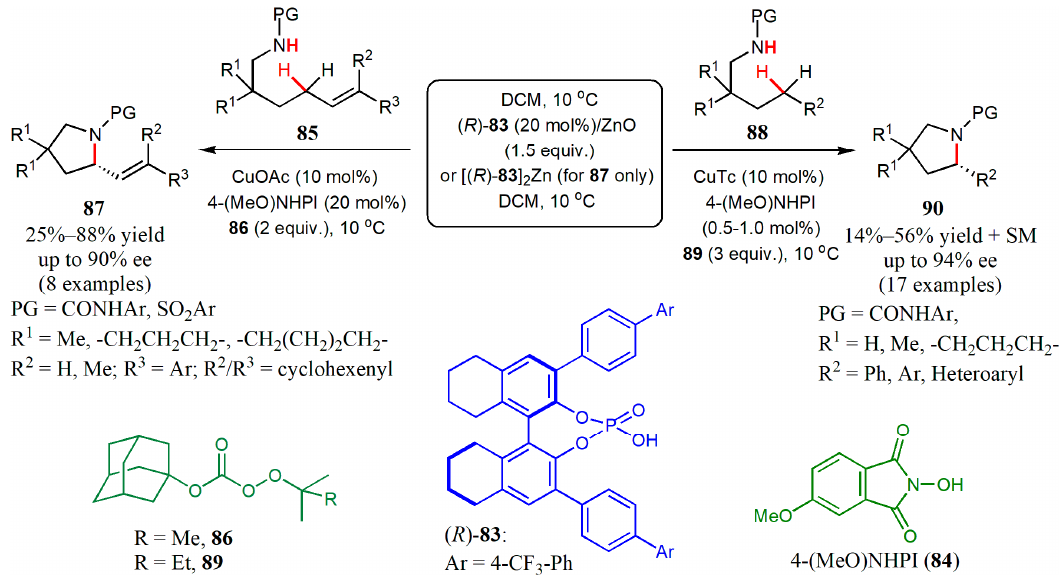
Figure 26. Enantioselective copper-catalyzed intramolecular amination of allylic and benzylic C–H bonds.